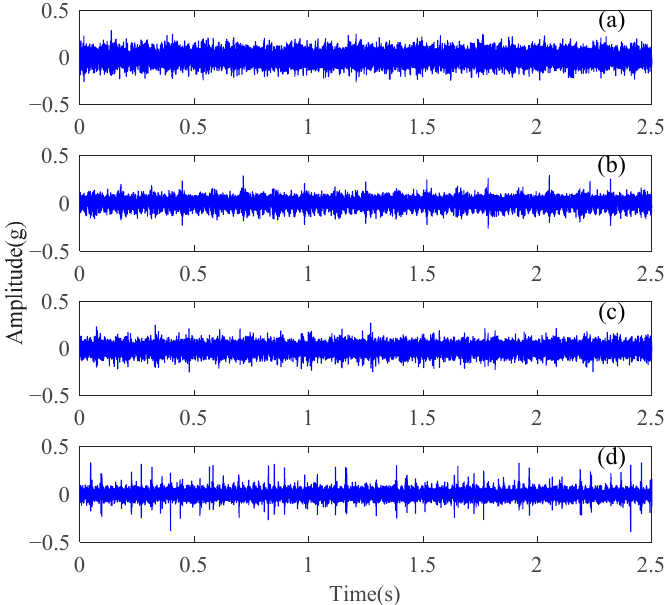
Figure 13. Time-domain vibration signals of breakage degradation: ( a ) normal gear, ( b ) one-quarter breakage, ( c ) one-half breakage, and ( d ) three-quarters breakage.